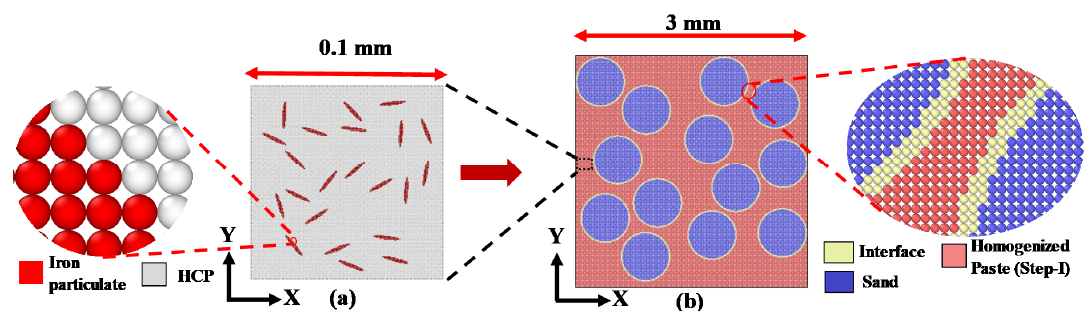
Figure 4. Interactive length scales: ( a ) Step I: 10% iron powder dispersed in hardened cement paste (HCP) matrix at micro-scale; ( b ) Step II: sand embedded in homogenized iron powder- HCP at meso-scale (the homogenized material from ( a ) serves as matrix for ( b )).